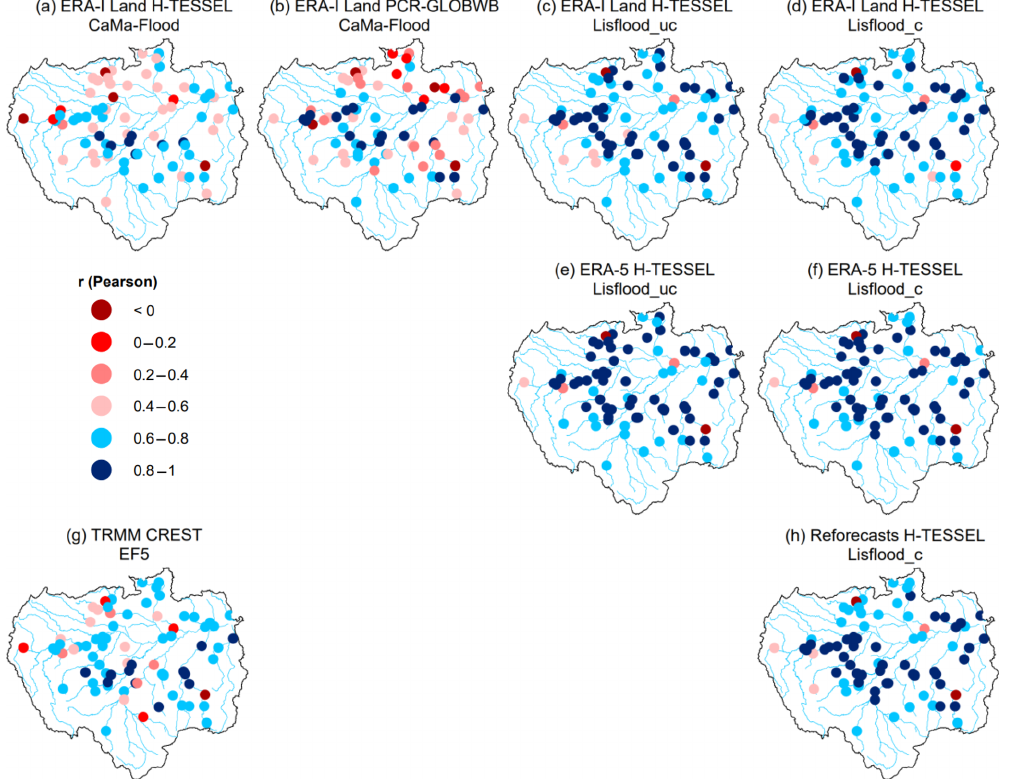
Figure 3. Correlation component (Pearson’s) of the KGE at the 75 hydrological gauging stations for all simulations. For the periods 1997– 2015 and 2004–2015 for the Coupled Routing and Excess Storage, Ensemble Framework for Flash Flood Forecasting (CREST EF5) run (g). Values greater than 0.6 are considered skilful (i.e. blue circles). Table 2. Median scores for the 75 hydrological gauging stations for all metrics. Model